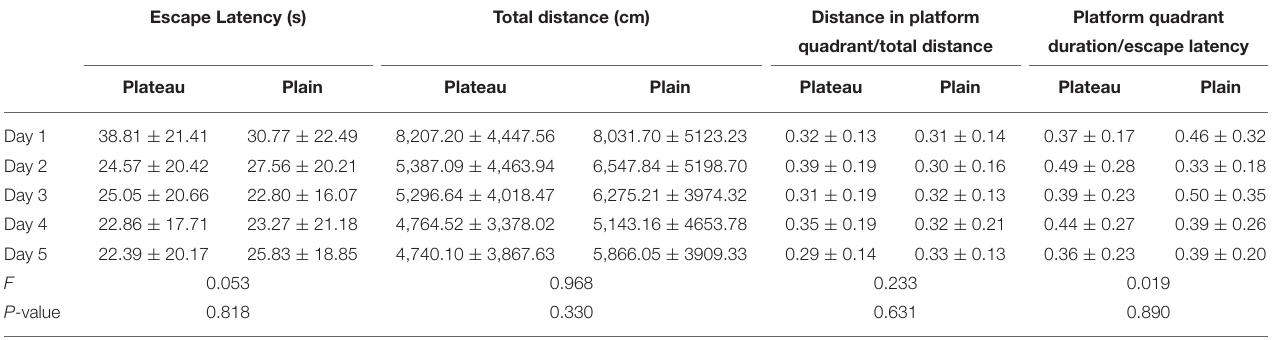
TABLE 4 | Analysis of place navigation of the Morris water maze. Escape Latency (s) Total distance (cm) Distance in platform Platform quadrant quadrant/total distance duration/escape latency Plateau Plain Plateau Plain Plateau Plain Plateau Plain